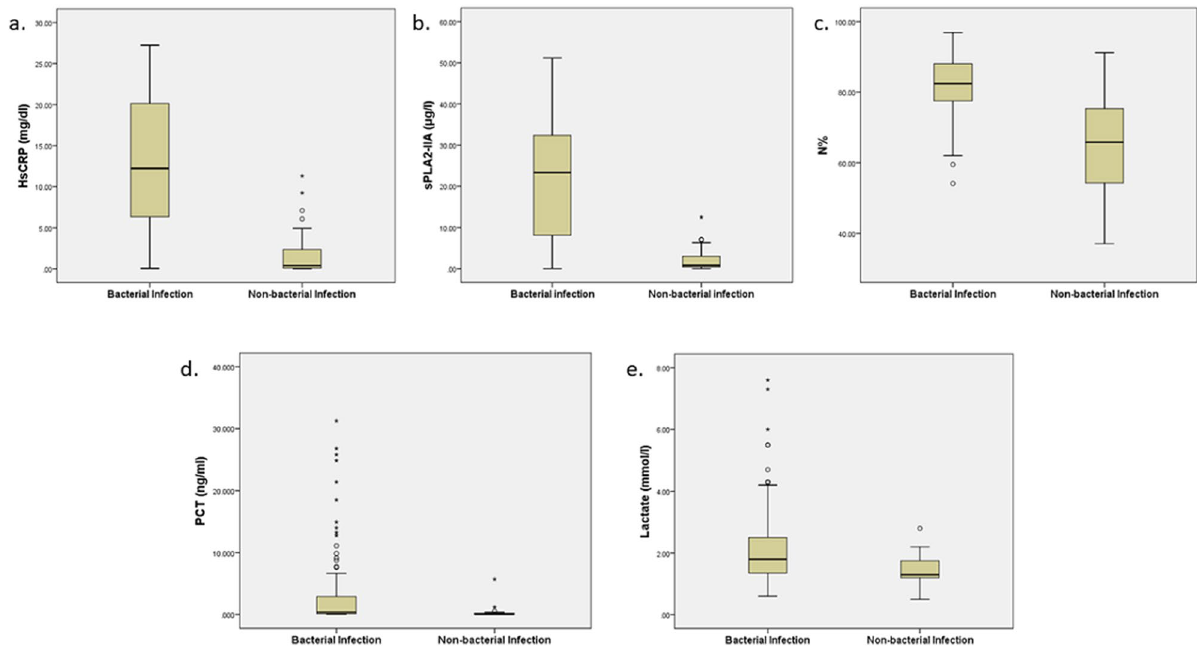
Figure 2. Box plots for high-sensitive CRP, sPLA2-IIA, N%, PCT, and lactate levels in detecting bacterial infection. hsCRP = High-Sensitive C-Reactive Protein; sPLA2-IIA = Secretory Phospholipase 2-IIA; N% = Neutrophil Percentage; PCT = Procalcitonin . Boxes show the 25th–75th centiles, while whiskers indicate the 10th and 90th centiles. Horizontal lines within the boxes indicate the median. Outliers are shown as circles and stars.